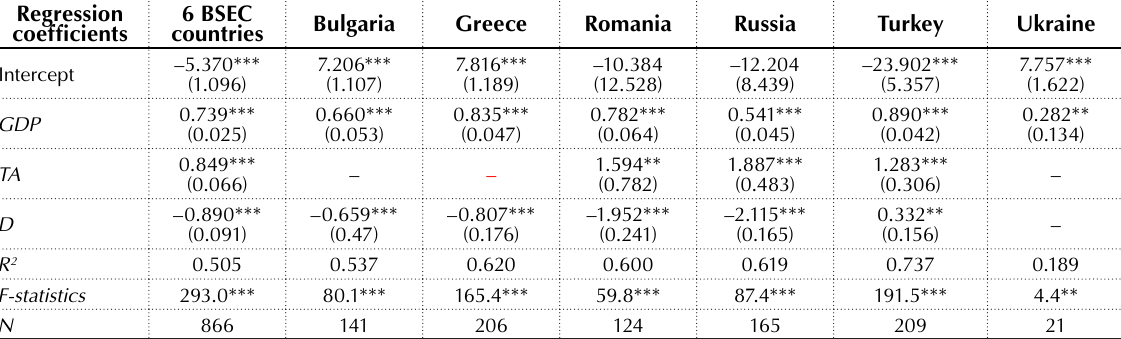
Table 6. Regression results for number of trips of the EU residents to the 6 BSEC countries Sources: Authors’ calculations according to the data of Eurostat, World Bank and DistanceFromTo. Regression